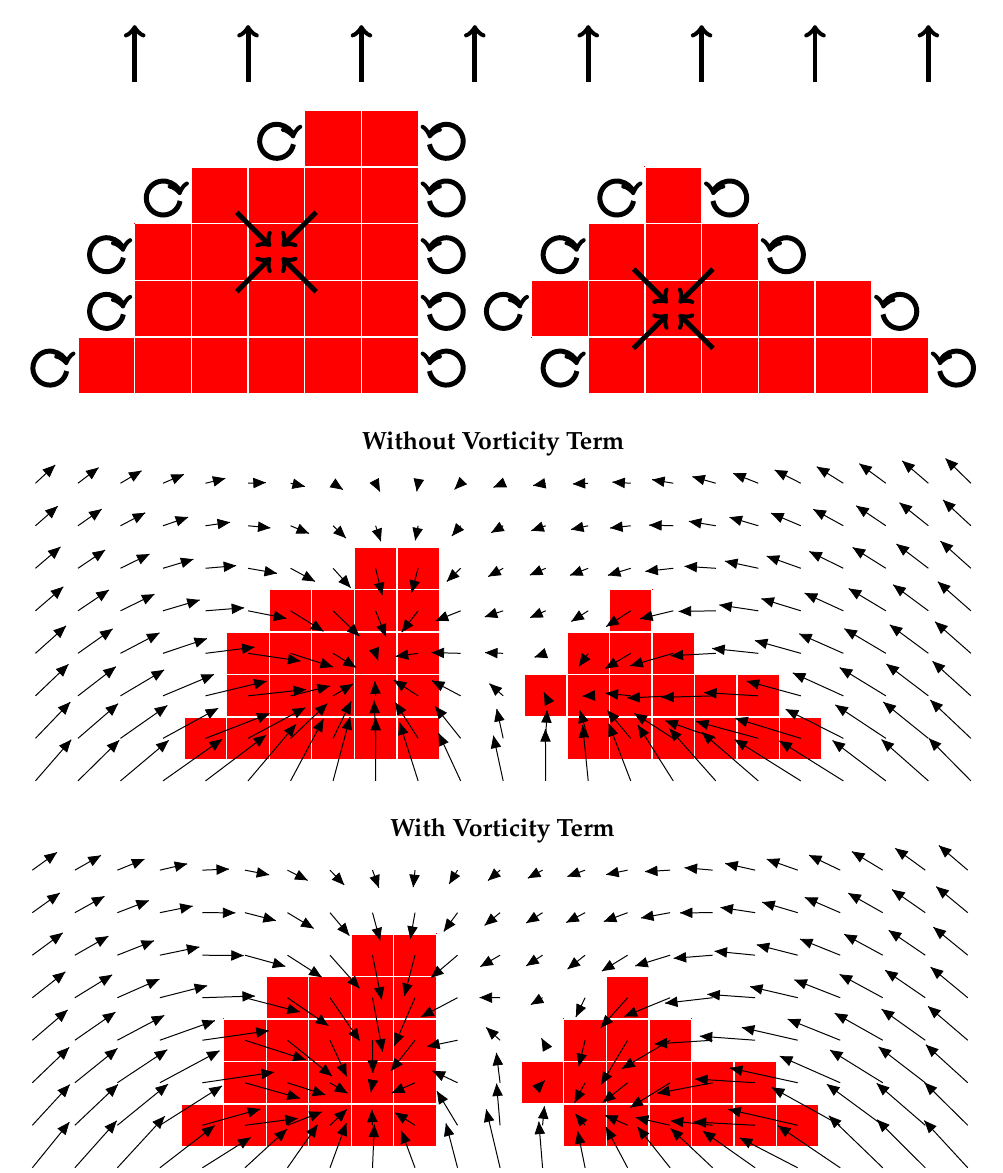
Figure 1. Wind around combusting elements (indicated by red cells). The atmospheric velocity is the sum of three components: background flow, pyrogenic potential, and vorticity along the